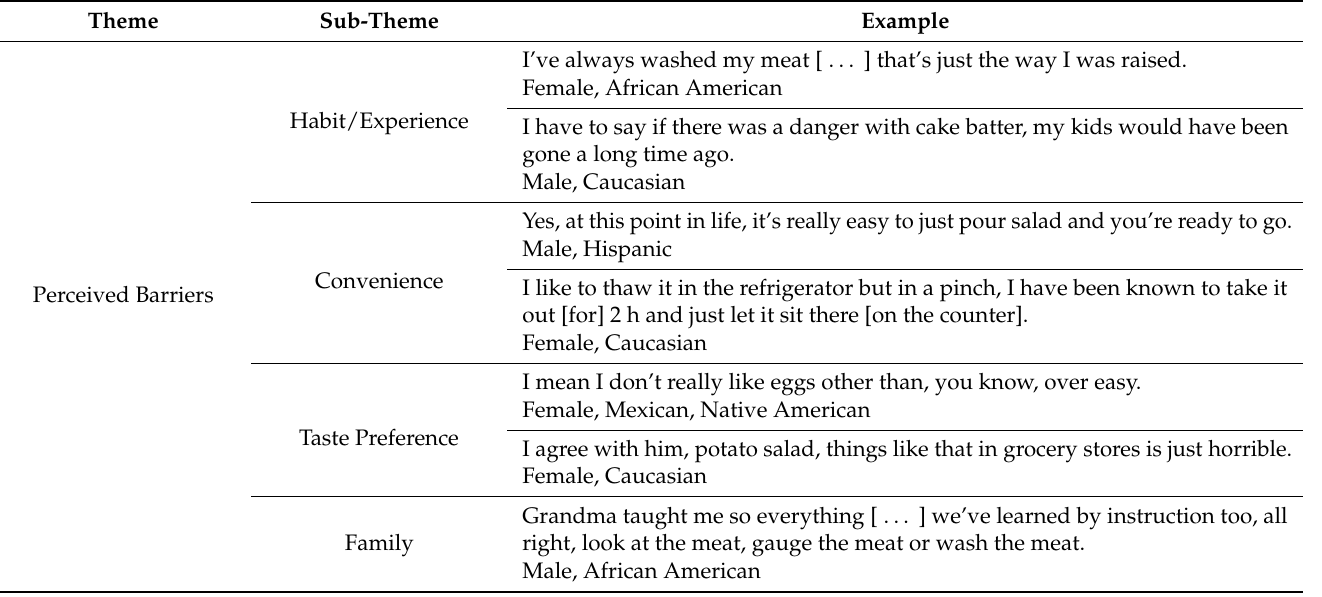
Table 7. Supporting quotes from a thematic analysis of the focus group discussions related to the Health Belief Model construct, perceived